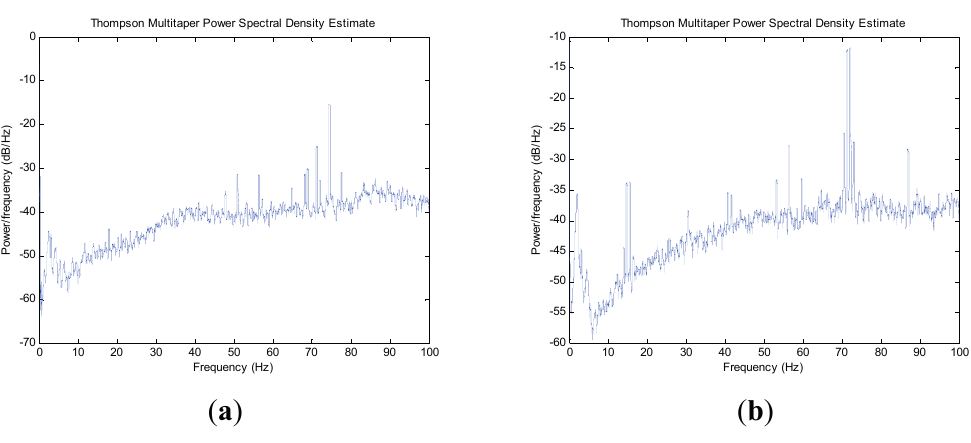
Figure 3. Spectral analysis of force observation in vehicle outdoor: ( a ) in X direction; ( b ) in Y direction; ( c ) in Z